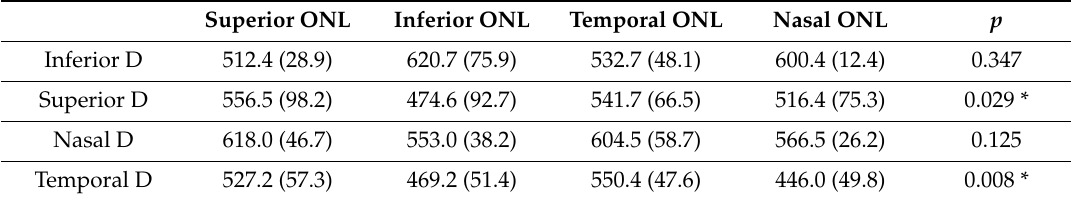
Table 4. Comparison of the outer nuclear layer (ONL) and visual field defect (D) in hydroxychloroquine retinopathy (HCQR) eyes. Data for quantitative variables are shown as mean (standard deviation). Analysis was performed using the Kruskal–Wallis test. * p -value is <